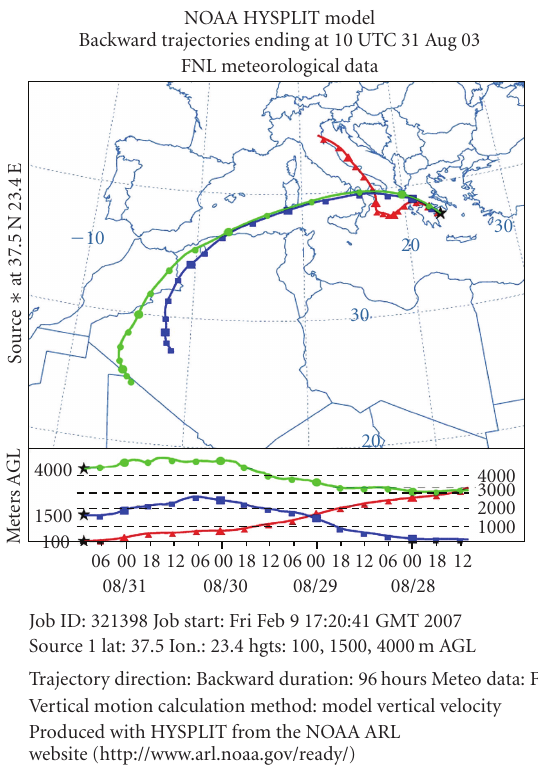
Figure 2: Air-mass back trajectories computed from NOAA-HYSPLIT model over AA (a) on 22/6/03, (b) on 4/7/03, (c) on 14/7/03, (d) on 15/8/03, and (e) on 31/8/03.